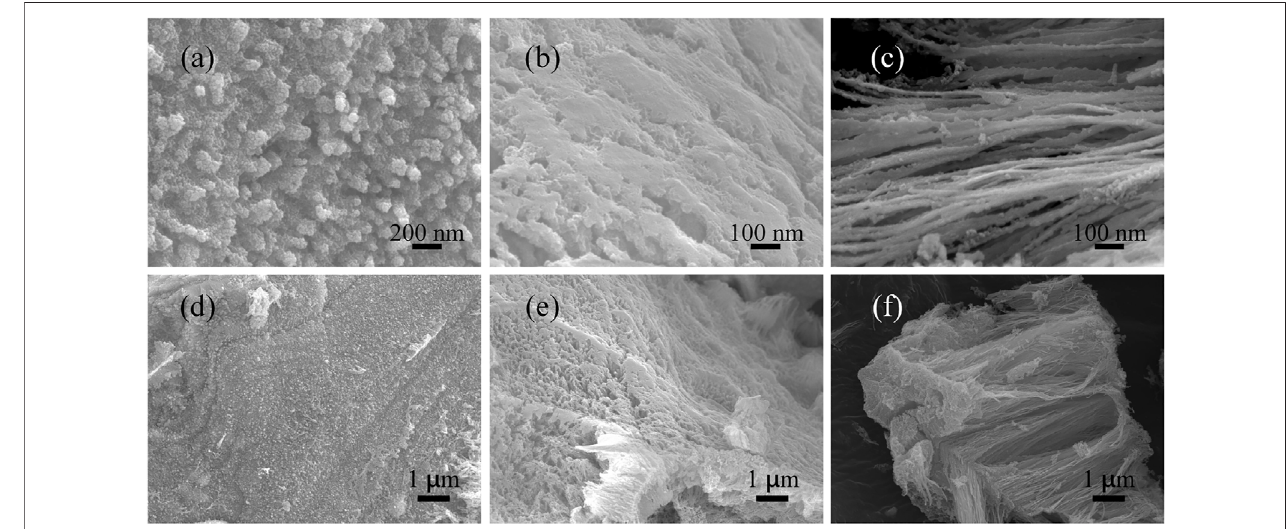
FIGURE 4 | SEM images of obtained samples from different reaction times: (A, D) 3 h; (B, D) 7 h; (C, F) 30 h.